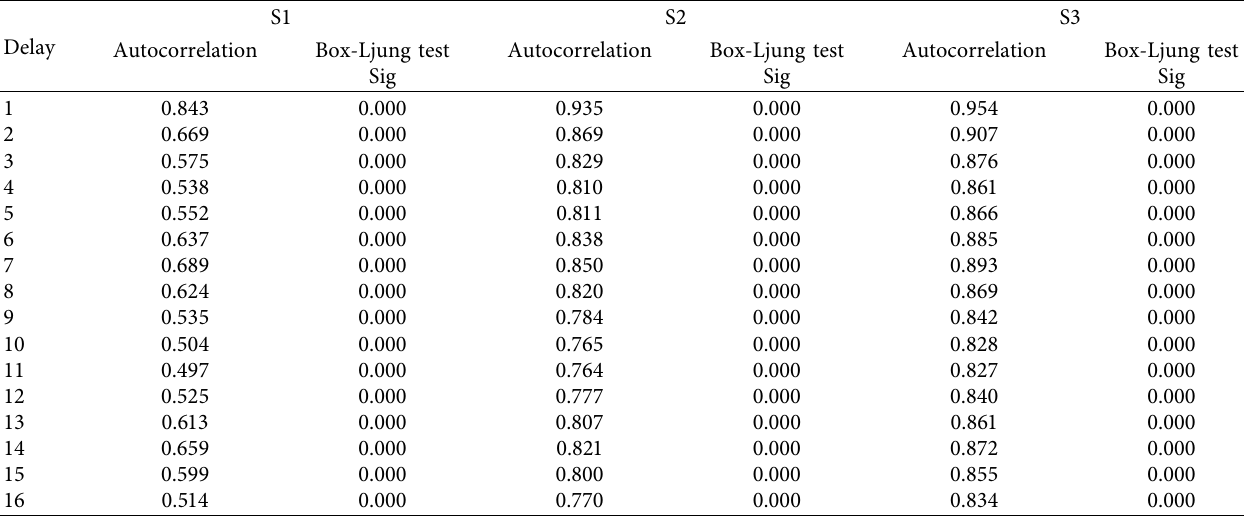
Table 3: Autocorrelation test of the dependent variables.